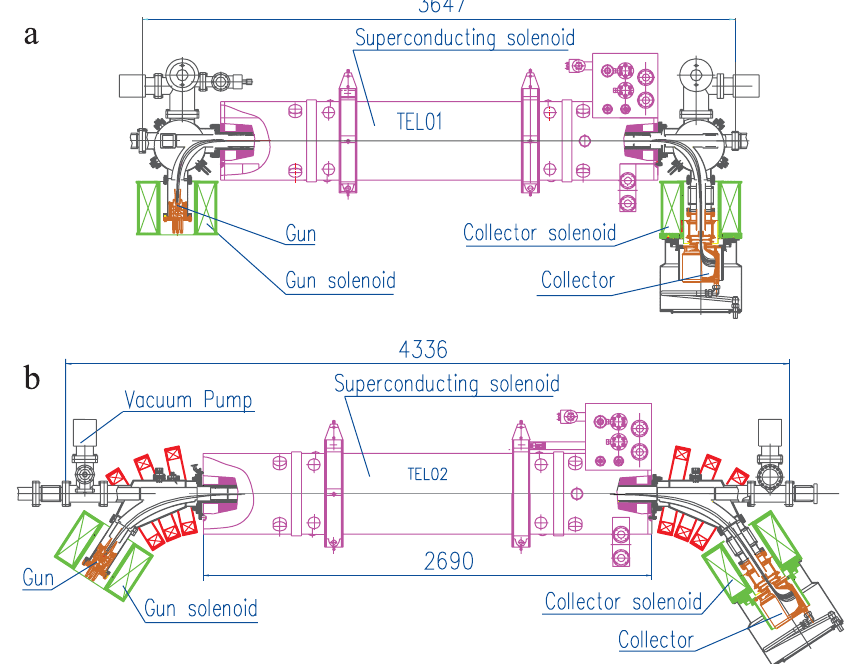
FIG. 1. (Color) (a) General layout of the TEL-1 installed at F48 location, top view. (b) General layout of the TEL-2 installed at A11 location, top view.